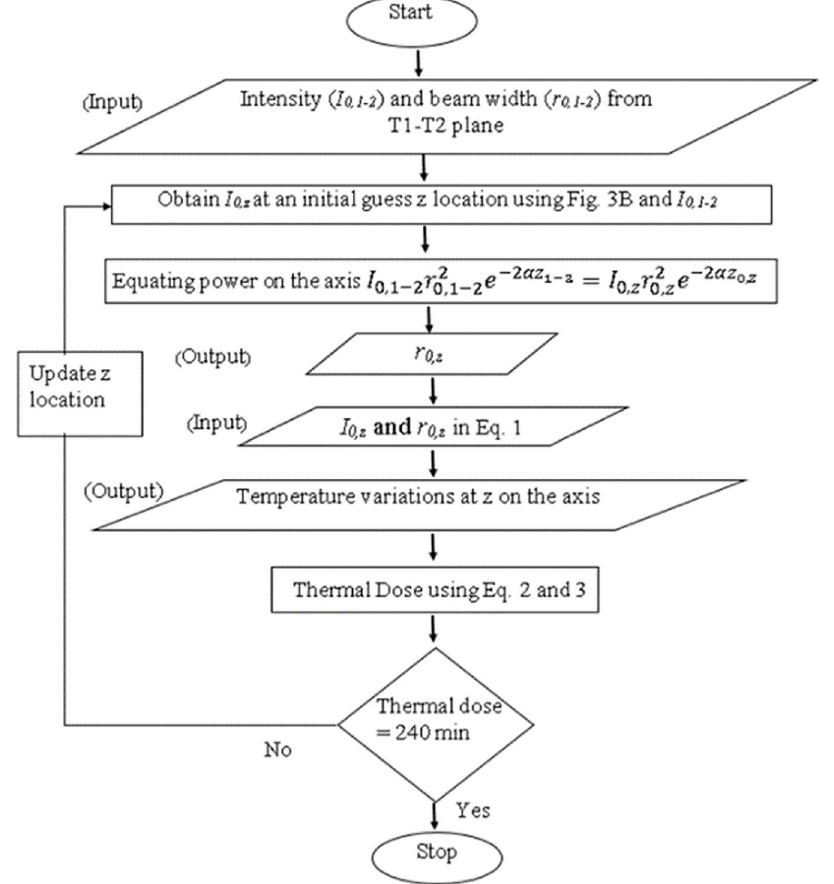
Fig 6. Flow chart to determine the z location with thermal dose of 240 equivalent minutes.